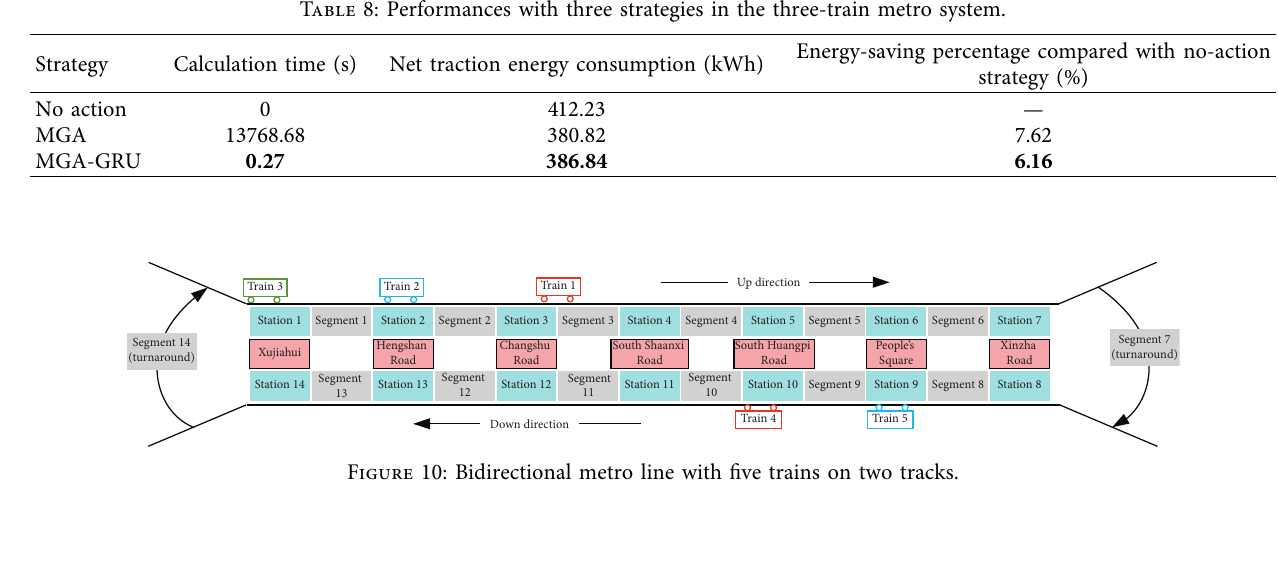
Table 9: Performances with three strategies in the five-train metro system.